Question: What form of chart is displayed?
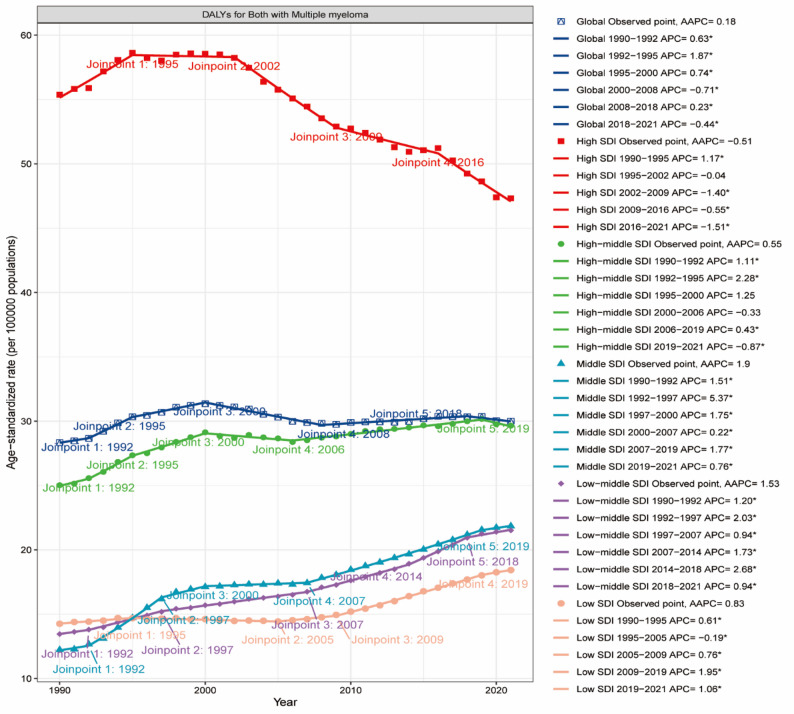
Answer: line